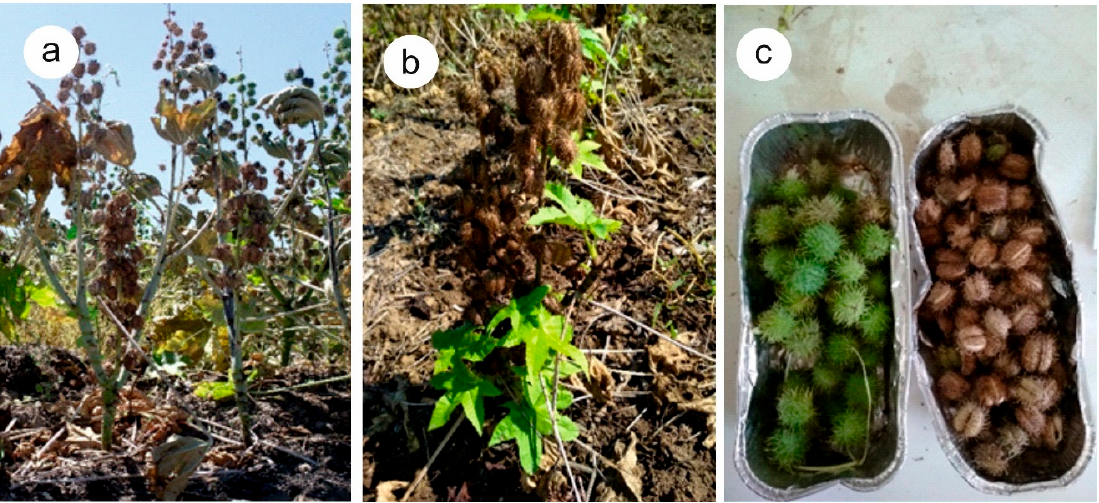
Figure 6. ( a ) Castor plants shocked by the chemical in DEF treatment on 30 August 2021. ( b ) New leaves emerged in DEF treatment on 13 September 2021 ( c ) Fresh ( left ) and dry ( right ) capsules collected from CON and DIQ on 10 September 2021.